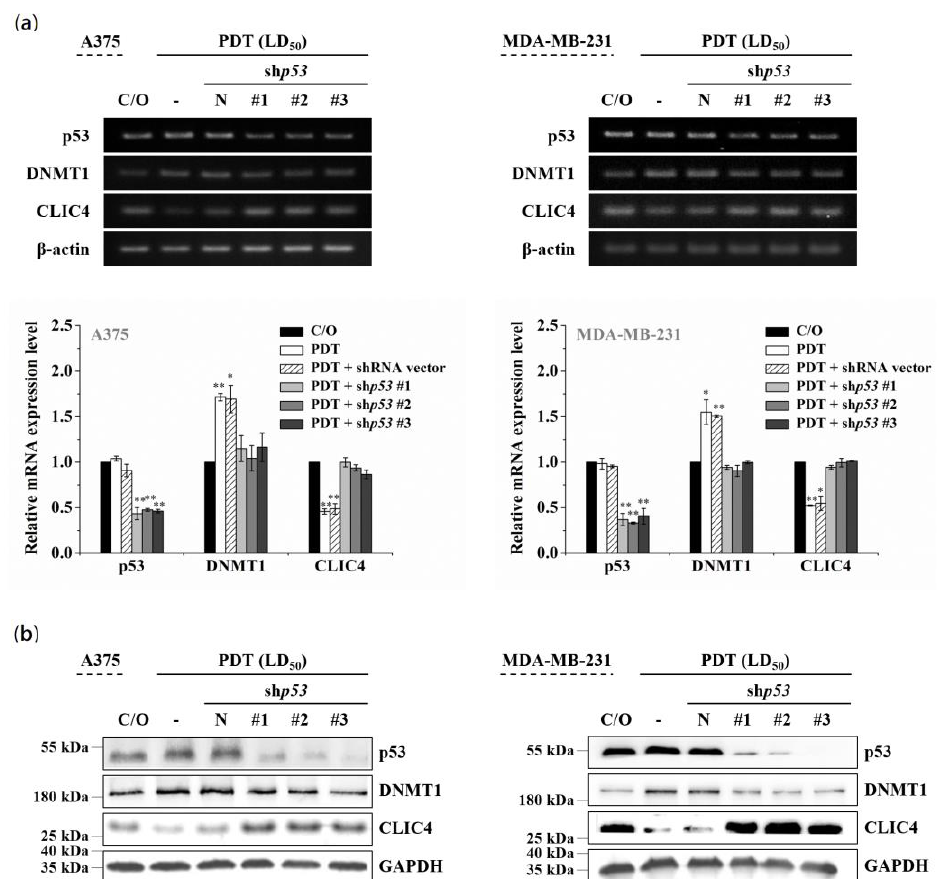
Figure 5. p53 involves in the altered expression of DNMT1 and CLIC4 in PDT-treated cells. A375 (left panel) and MDA-MB-231 (right panel) cells were transfected with either the shp53 (denoted as #1, #2 and #3) or an empty shRNA vector (pLKO.1 as negative control). ( a ) Total mRNA and ( b ) protein samples were isolated from cells 24 h after ALA-PDT. The light dose for A375 and MDA-MB-231 cells is 2 J/cm 2 and 4 J/cm 2 , respectively. The relative mRNA expression level of each gene was measured by RT-PCR and normalized to β -actin. The control group was cells only treated with ALA w/o light irradiation. For electrophoretic gels, the same volume of each PCR product was loaded, and band blots for each gene were cropped from different gels. For immunoblots, equal volume of each sample with the same concentration was loaded into each well, and the blots were cropped from different sections of the same gel. Data represent from three independent experiments. Each bar shown is the mean fold change relative to control ± SD. Results are considered to be statistically significant at * p < 0.05 and ** p < 0.01.